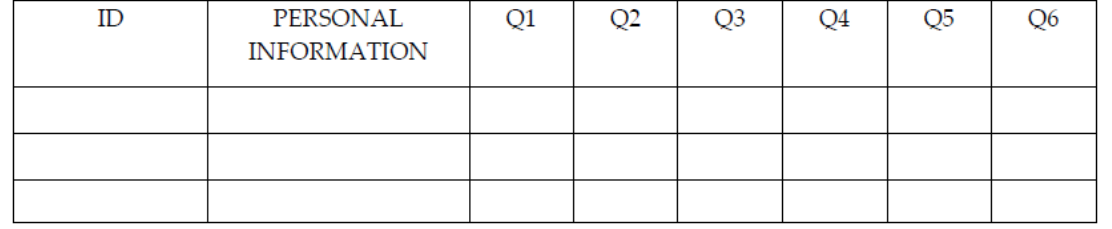
Figure 2. Sheet Register of the New Version of Mode and Frequency of commuting to and from school questionnaire for Students’ doubts. Notes: ID, Identification number; Q, Question.